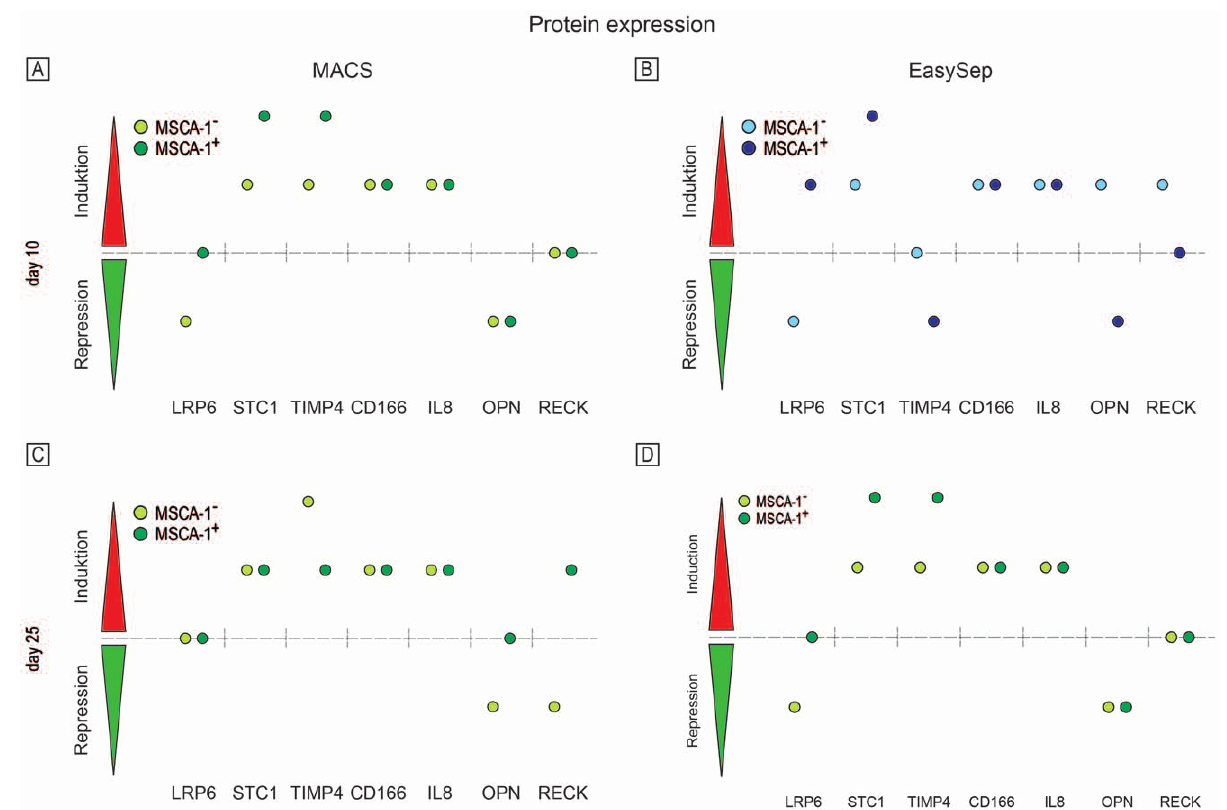
Figure 5. Protein expression analysis in supernatants from MACS- (A, C, bright and dark green spots) and EasySep-separated (B, D, bright and dark blue spots) MSCA-1 + / 2 cells were analyzed at days 10 and 25 of the osteogenic differentiation (n=3 for each separation method) compared with the untreated controls. Protein expressions of LRP-6, STC-1, TIMP-4, CD166, IL-8, OPN and RECK were illustrated over the baseline in the case of induction (red) and under the line in the case of repression (green).